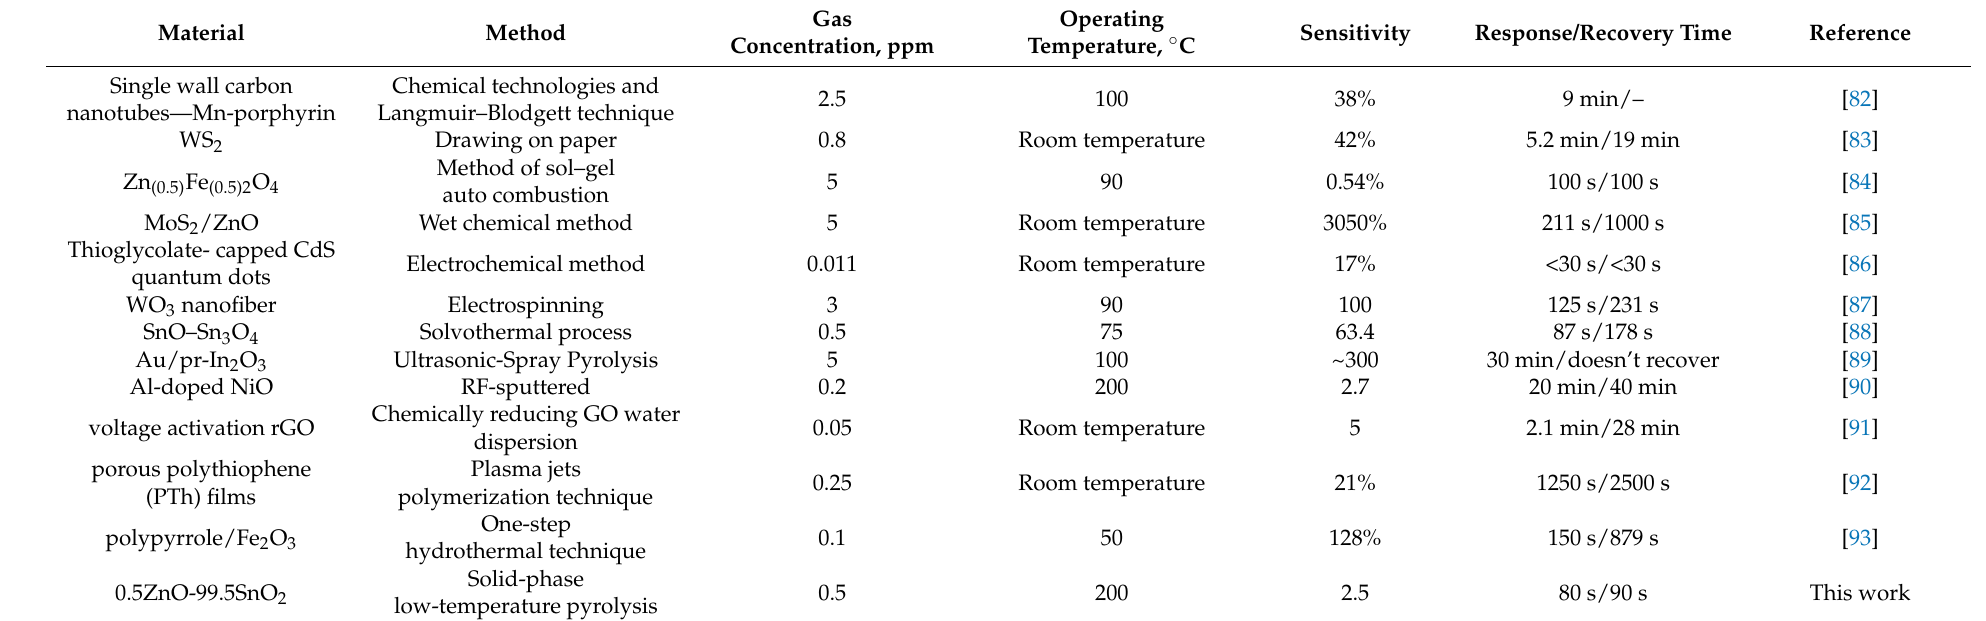
Table 5. Gas-sensitive characteristics of NO 2 sensors based on other